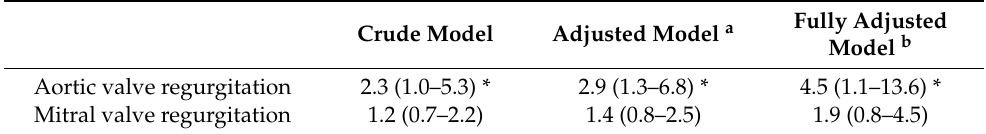
Table 5. Association of AS with valve